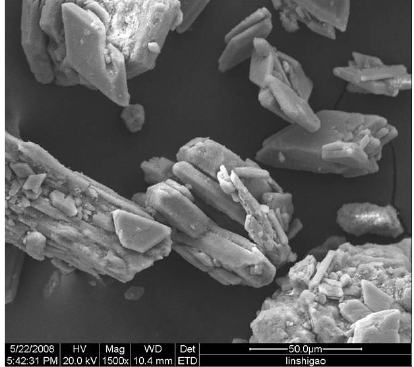
Figure 3. SEM of phosphogypsum raw material. Other materials used in the study were ethylene glycol, ethanol, anhydrous ethanol of benzoic acid, potassium iodate standard titration solution and sodium thiosulfate standard titration solution (A Technology Co., Ltd., Xi’an,